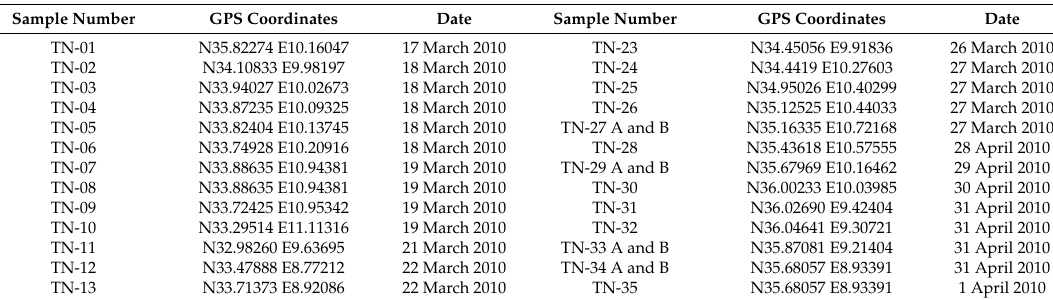
Table 1. Sampling sites in